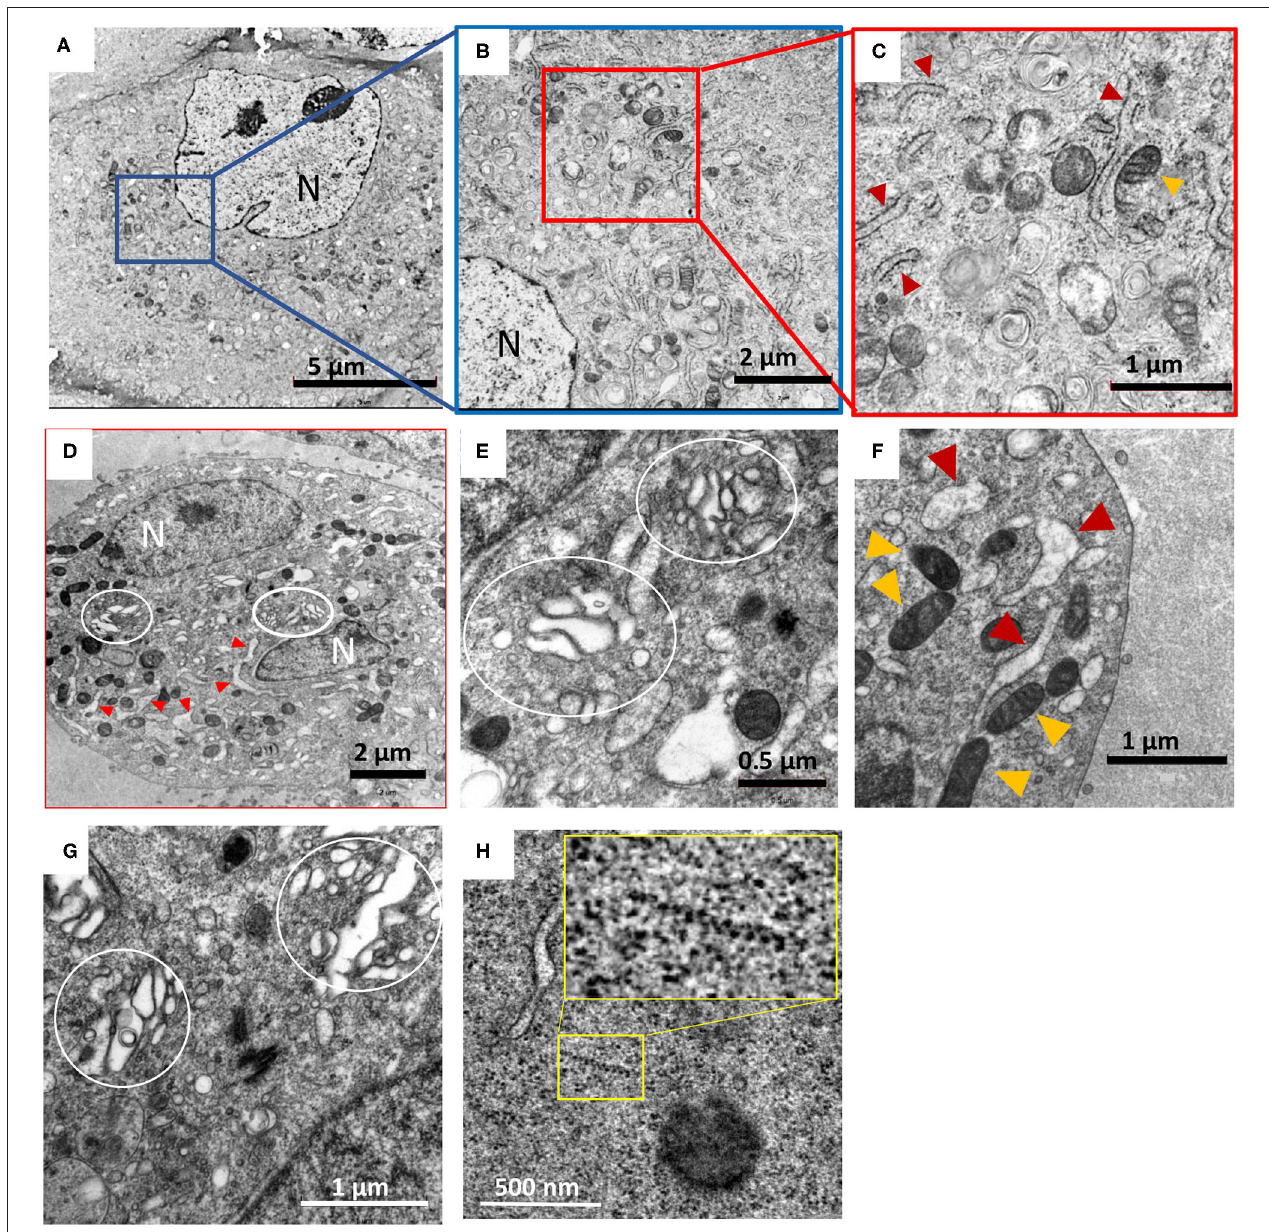
FIGURE 1 | Hybrid chemical-cryo fixation of cells in conjunction with extended freeze substitution imparts excellent ultrastructural preservation of HTNV infected Vero E6 cells. Images (A) through (D) were collected at 5,000–6,000 X magnification and (E) through (H) were collected at 13,500–25,000 X magnification. (A,B,C) are images of mock infected Vero E6 cell, processed by HPF-extended FS (ex-FS) method. (D–H) Show changes in cells due to hantavirus infection. N, indicates nucleus, with red and orange triangles denoting rough ER and mitochondria, respectively. (D,E) HTNV infected cells at 7 days post infection exhibit distended and fragmented Golgi apparatus (marked by white circles). (F) Swelling of the rough ER is widespread and is a hallmark of HTNV infection along with Golgi unstacking and fragmentation (E,G) . (H) Typical features of HTNV infection such as distended Golgi apparatus and wide-spread polyribosomes [yellow box and magnification of the area within the box in inset, (H) ] were also observed. The term distended refers to the swelling and loss of tight Pan cake like stacked morphology we noted similar to that reported by others (Salanueva et al., 2003; Lazaro-Dieguez et al., 2006). between non-infection induced stress and virus induced stress in the cells after the duration of infection. After fixation and confirmation of inactivation, HTNV-infected Vero E6 cells were removed from BSL-3 and processed using the HPF-ex-FS protocol (Sengupta et al.,